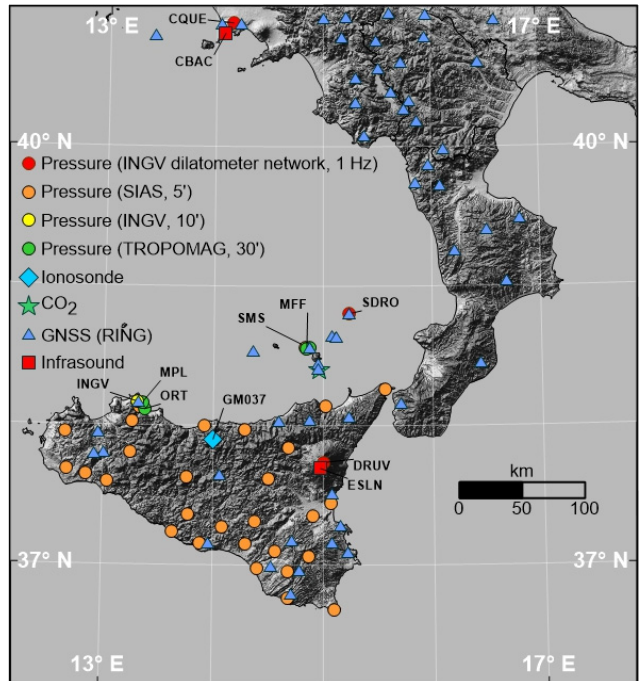
Figure 1. Location of the stations considered in this study, classified for acquired parameter and sampling periodicity.